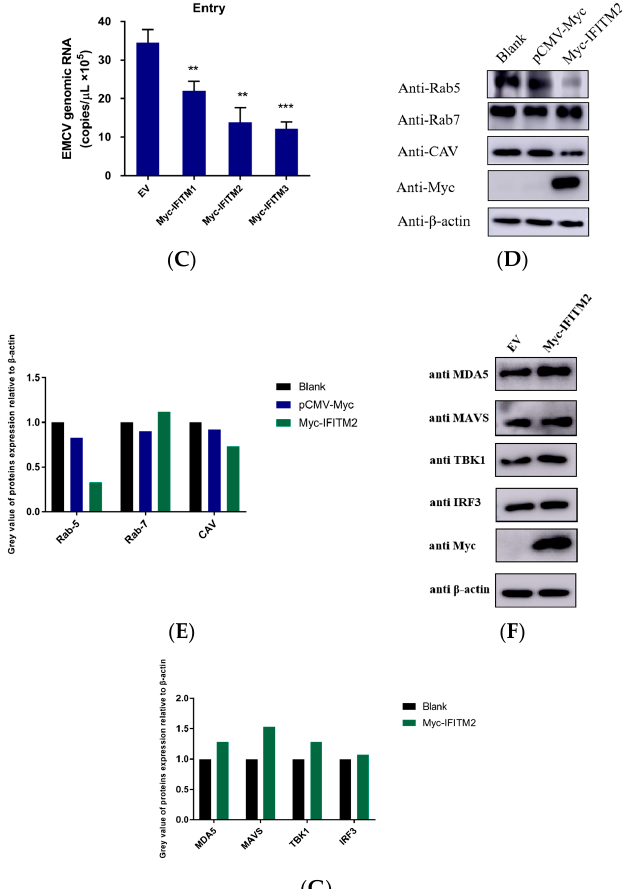
Figure 5. ( A ) HEK293 cells were transfected with pCMV-MyC-IFITM2 (1 µ g) and pCMV-Myc (1 µ g), respectively. Cells were stimulated 24 h post-transfection with 0.001 MOI EMCV for another 12 h. Then, cells were collected, and RNA was extracted for MDA5, MAVS, TBK1, and IRF3 detection via RT-qPCR. All values were normalized to the level of β -actin mRNA. Data were expressed as mean ± SDs from three independent experiments and were measured in technical duplicate. Comparisons between groups were performed using the Student’s t -test. *** p < 0.001. ( B ) HEK293 cells overexpression of IFITM proteins were used for the viral adsorption experiment. Cells were infected with EMCV at an MOI of 0.001. Then, cells were incubated at 4 ◦ C for 2 h, washed 4 times with cold PBS, and collected for RNA extraction. real-time PCR was applied to detect virus copies bound to the cell surface. ( C ) HEK293 cells overexpression of IFITM proteins was used for viral entry assay. Cells were infected with EMCV at an MOI of 0.001. Then, cells were incubated at 4 ◦ C for 2 h, washed 4 times with cold PBS, incubated at 37 ◦ C for another 2 h, then cells were washed with PBS and treated with 0.05% trypsin, washed 4 times with cold PBS, and collected for RNA extraction. The viral entry into cells was detected via real-time TaqMan PCR. Data were expressed as mean ± SDs from three independent experiments and were measured in technical duplicate. Comparisons between groups were performed using the Student’s t -test. *** p < 0.001, ** p < 0.01. ( D ) HEK293 cells were transfected with pCMV-MyC-IFITM2 (1 µ g), and cells transfected with pCMV-Myc (1 µ g) served as control. Cells were collected 24 h post-transfection, and cellular protein was extracted for Rab5, Rab7, and Caveolin-1 detection via Western blotting. β -actin served as a loading control. ( E ) Greyscale analysis was used to measure the protein expression level relative to β -actin. ( F ) HEK293 cells were transfected with pCMV-MyC-IFITM2 (1 µ g), and cells transfected with pCMV-Myc (1 µ g) served as control. Cells were collected 24 h post-transfection, and cellular protein was extracted for MDA5, MAVS, TBK1, and IRF3 detection via Western blotting. β -actin served as a loading control. ( G ) Greyscale analysis was used to measure the protein expression level relative to β